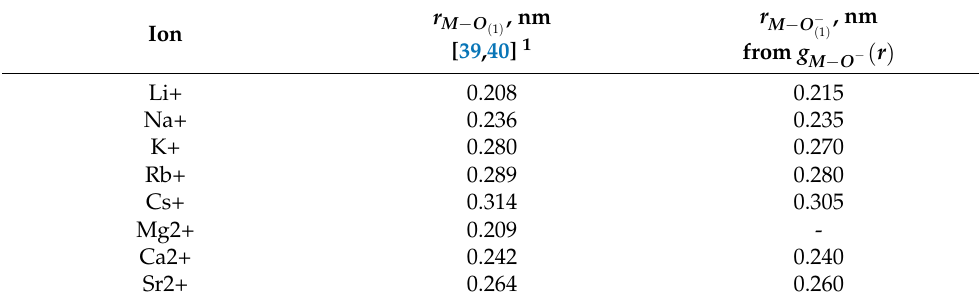
Figure 2. Radial distribution functions (RDF) between the oxygens of the spodumene (110) surface (O-) and the metal cations (M) for different salt solutions, g M − O − (r), where M corresponds to monovalent alkali metal cations ( a ) and divalent alkaline-earth metal cations ( b ). Surface charge density is − 0.125 C/m 2 . The first prominent peak for each salt solution corresponds to the first layer of cations adsorbed onto the spodumene surface. The cation concentration is 0.66 M and the temperature is 300 K. Data from Quezada and Toledo [5]. Table 1. Cation radii with first hydration shell, r M − O from the RDF in Figure , and r M − O − ( 1 ) ( 1 )